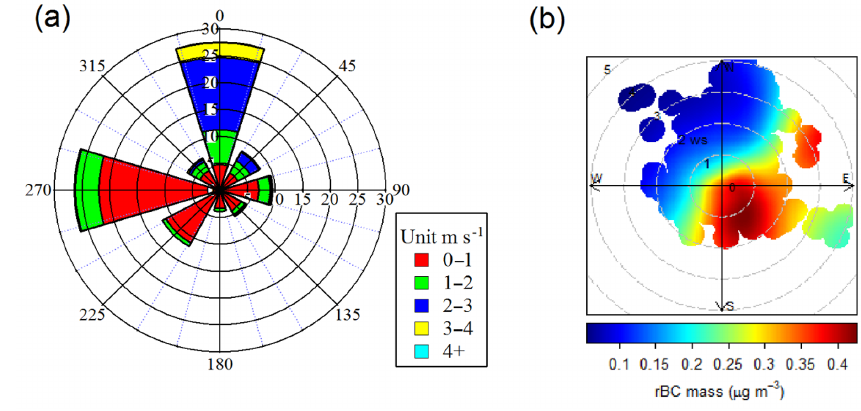
Figure 4. (a) Wind rose plot and (b) bivariate polar plot for the refractory black carbon (rBC) mass concentrations based on hourly data.